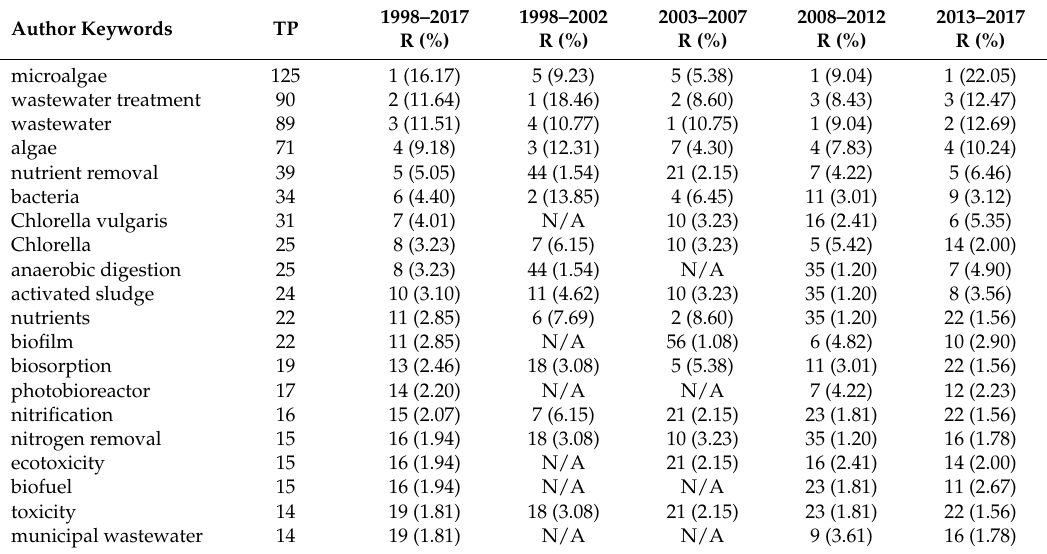
Table 6. Top 20 most frequently used author keywords in different periods during